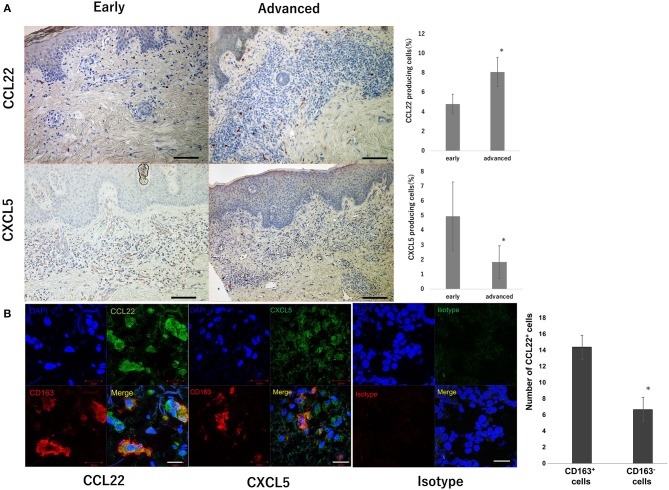
CCL22 producing cells in the lesional skin of MF. Representative paraffin-embedded tissue samples from the lesional skin at each stage of MF. Sections were deparaffinized and stained using anti-CCL22 or anti-CXCL5 antibodies. Three representative high-power fields of each section were selected from dermis associated with a dense dermal lymphoid infiltrate. Sections were developed with 3-Amino-9-ethylcarbazole. The percentage of CCL22+ and CXCL5+ cells was calculated as follows: CCL22+ cells or CXCL5+ cells/hematoxylin-positive cells × 100. Quantification of percentages of CCL22+ cells and CXCL5+ cells from 9 early CTCL patients and 16 advanced CTCL patients is shown. Scale bar, 100 μm. Error bar represents ± standard deviation (A). IF staining of CTCL for CCL22 (green), CD163 (red), and DAPI (blue, nuclei), and CXCL5 (green), CD163 (red), and DAPI (blue, nuclei). A merged image is also shown, with green and red combining into yellow. The isotype control IgG1 stains as red or green. Scale bar, 20 μm (B). Representative specimens from three cases are shown. The number of immunoreactive cells was counted at a magnification of × 400. The average of three independent fields in each sample was calculated (*p < 0.05). Error bar represents ± standard deviation.